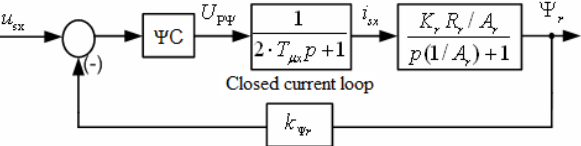
Figure 5 . Structure diagram of flux-linkage loop